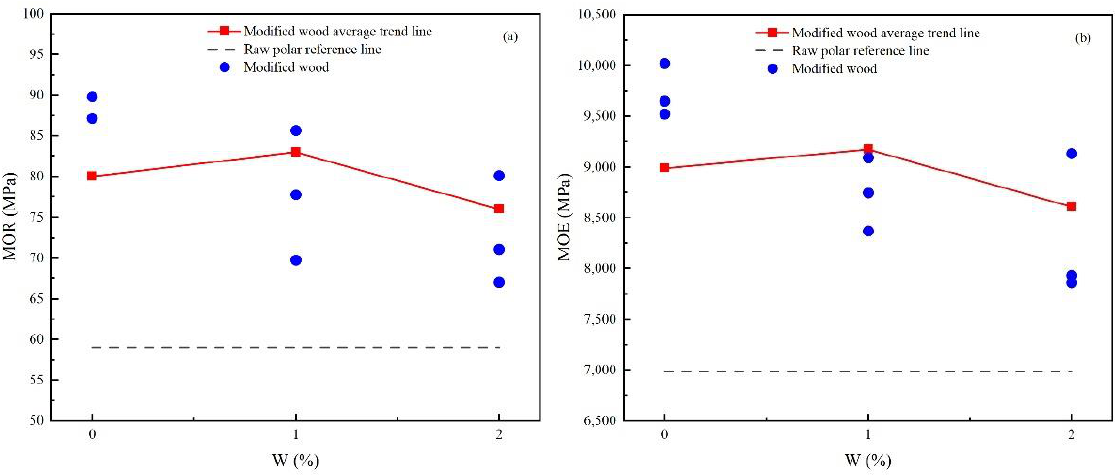
Figure 4. Comparative analysis of MOR and MOE of modified wood based on W: ( a ) MOR; ( b ) MOE.